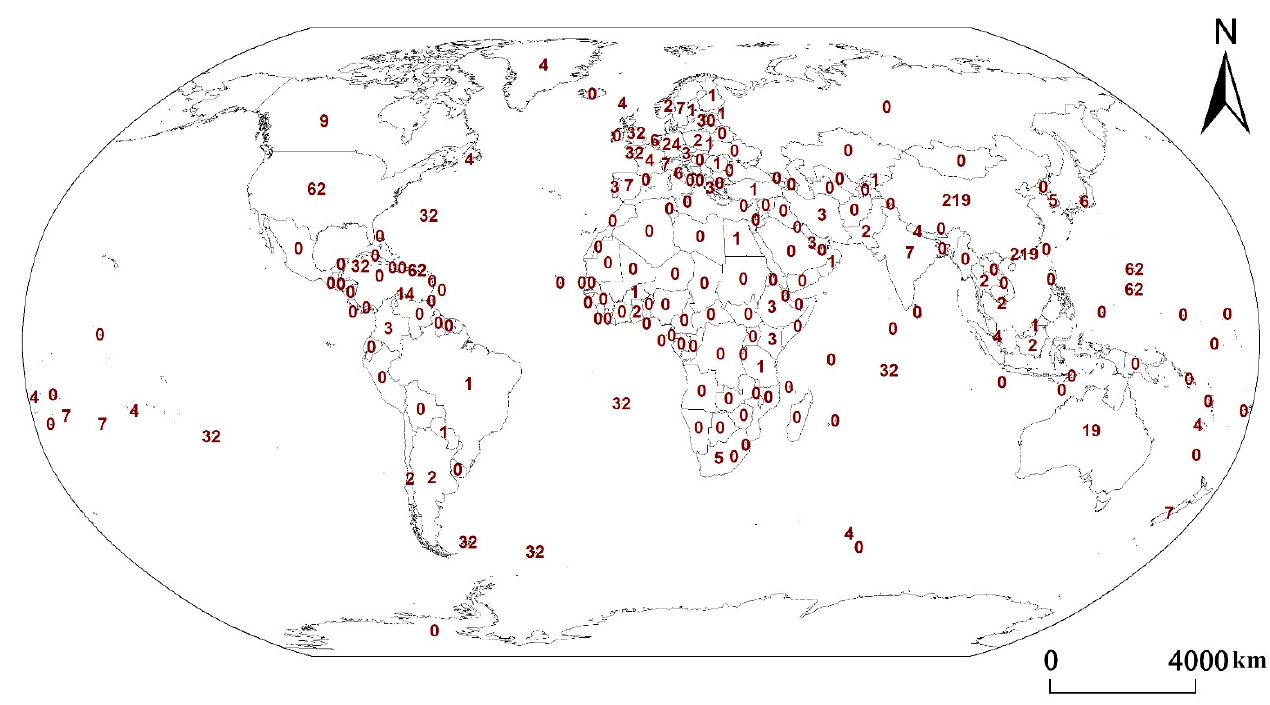
Figure 8. The distribution of the number of international trade-off studies. The numbers in the figure are the number of trade-off studies in each region.